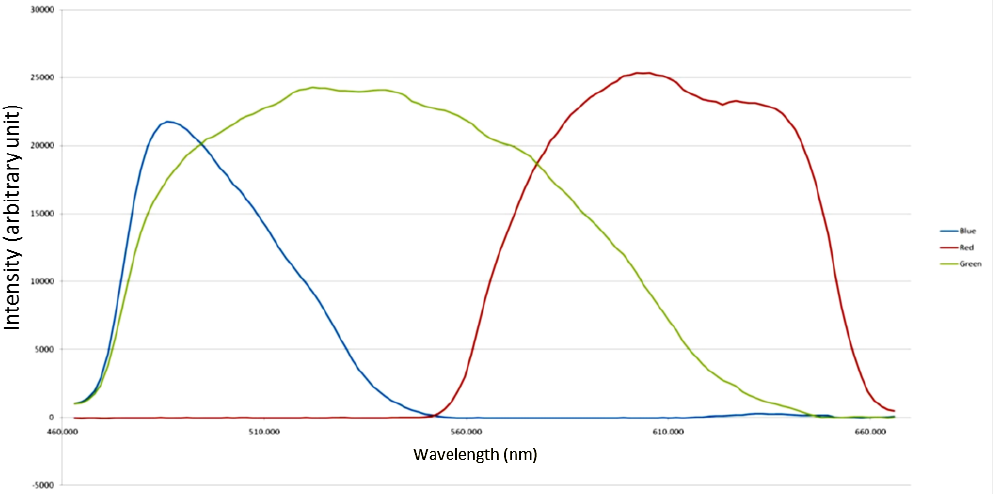
Figure 8. Detector response with white light illumination and a 475–650 nm bandpass filter. Each pixel is made of 3 layers. In each layer one of the three colors is detected. The three lines show the counts (arbitrary units) in the three different layers of the Foveon